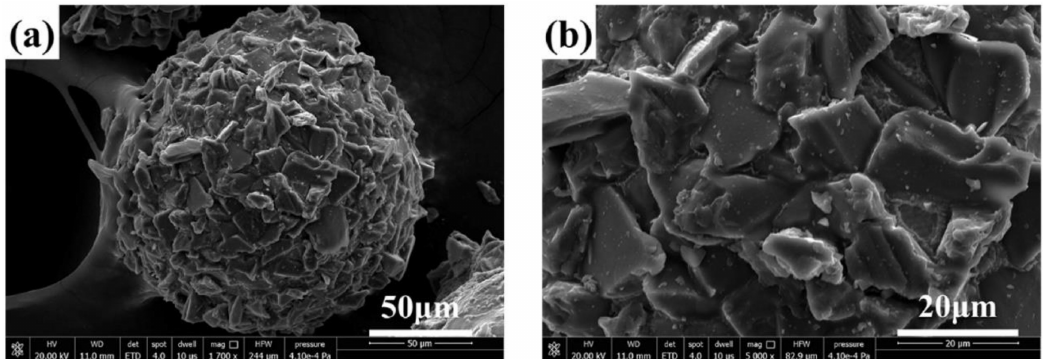
Figure 6. SEM micrograph of MAP: low-magnification ( a ) and high-magnification ( b ) [22].